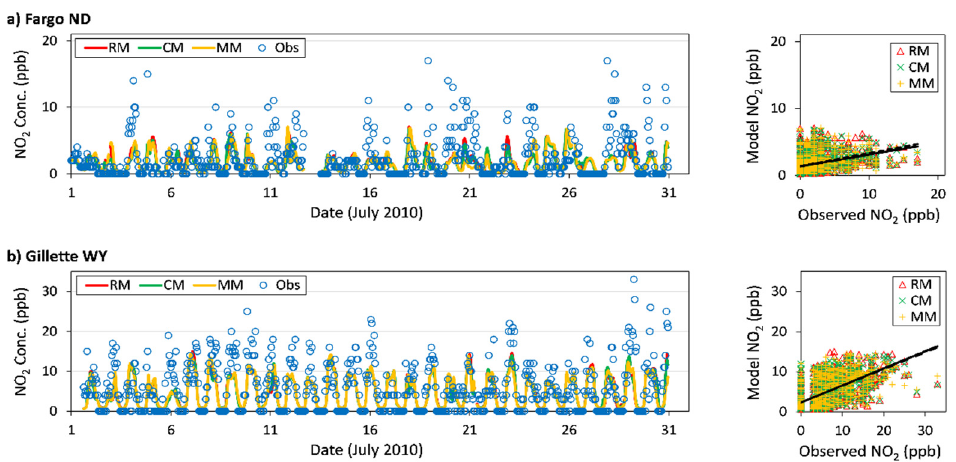
Figure 7. Hourly observed (Obs) and simulated NO 2 concentrations (ppb) from RACM- MADE/SORGAM (RM), CBMZ-MOSAIC (CM), and MOZART-MOSAIC (MM) chemistry-aerosol mechanisms. Time series shown on left, with scatter plots of simulated vs. observed values on the right for ( a ) Fargo, ND and ( b ) Gillette, WY.